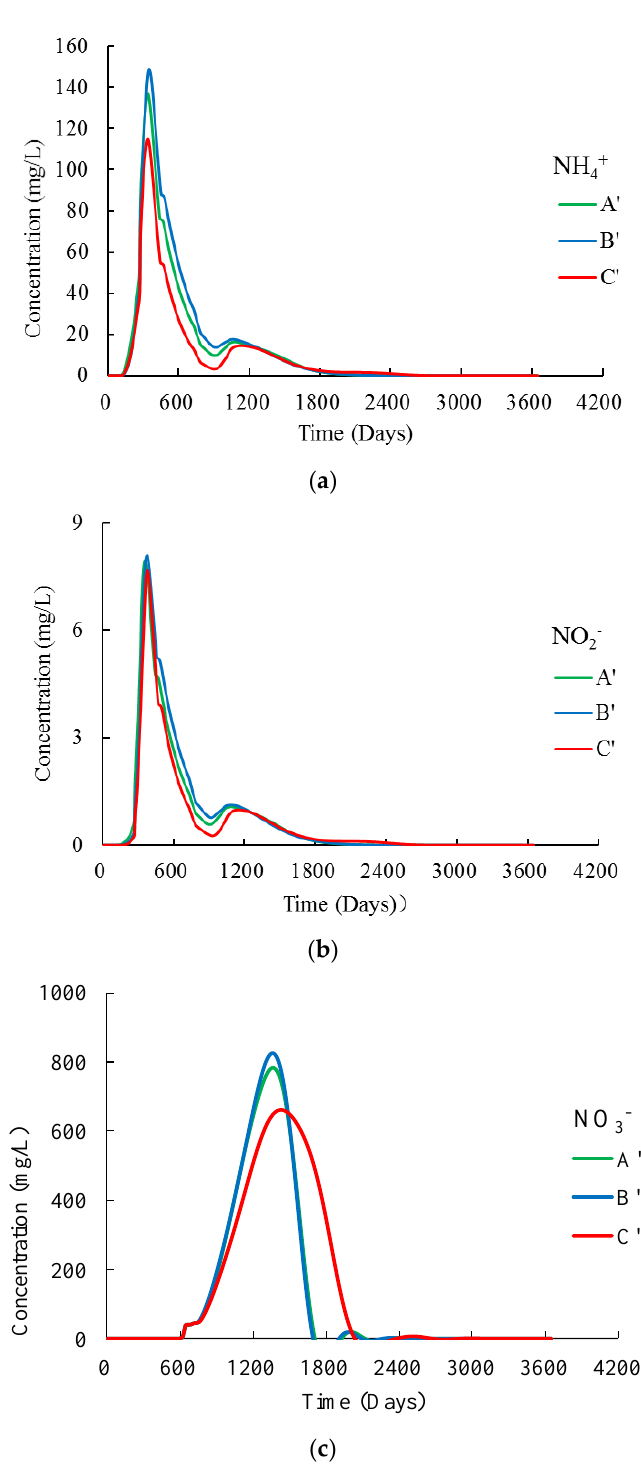
Figure 8. Temporal changes after the termination of sewage discharge for ( a ) NH 4+ ; ( b ) NO 2 − ; and ( c ) NO 3 − .